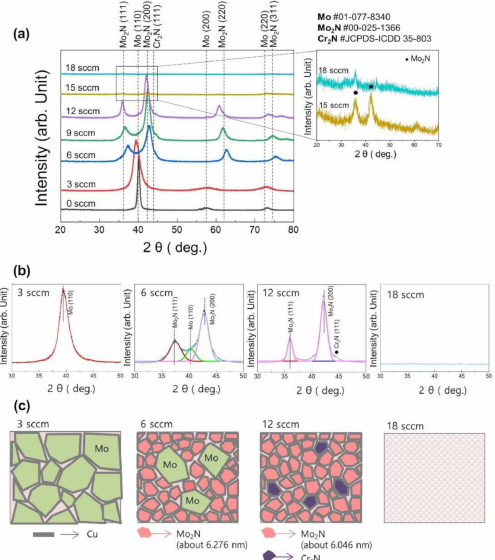
Figure 2. ( a ) XRD patterns of Mo–Cu–Cr–(N) coatings prepared at various N 2 gas flow rates and ( b ) fitted X-ray reflections for the samples prepared at 3, 6, 12, and 18 sccm. ( c ) Schematic of the microstructures of the coatings prepared at nitrogen gas flow rates of 3, 6, 12, and 18